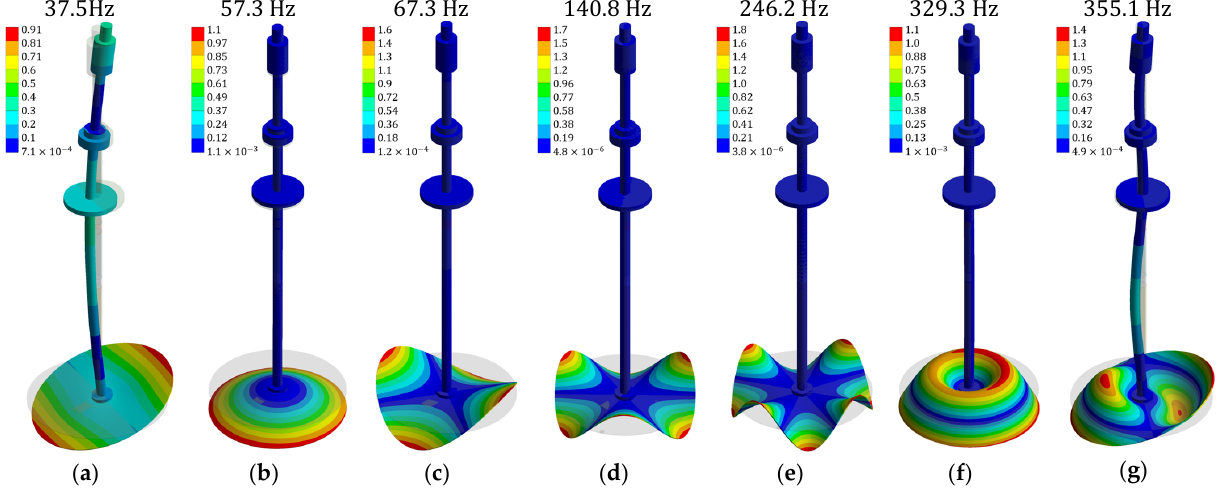
Figure 8. Numerical modes of vibration of the non-rotating disk in air: ( a ) 1ND; ( b ) 0NC; ( c ) 2ND; ( d ) 3ND; ( e ) 4ND; ( f ) 1NC; ( g ) 1NC + 1ND.